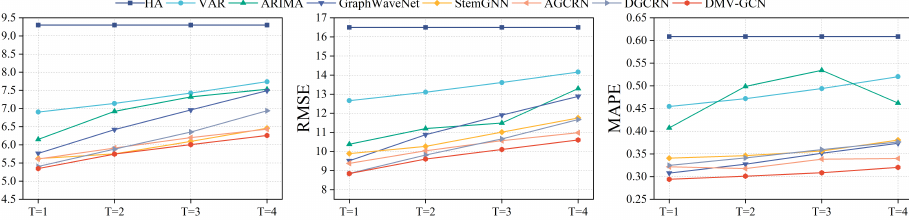
Figure 8. Comparison of the effect of different time-slice on